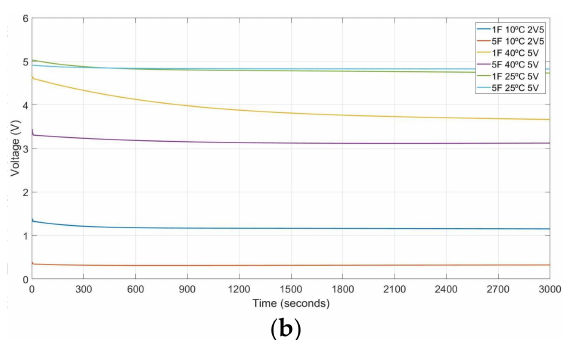
Figure 9. Obtained results with 3rd approach. ( a ) Charge curves at different conditions and their ( b ) self-discharge profiles.